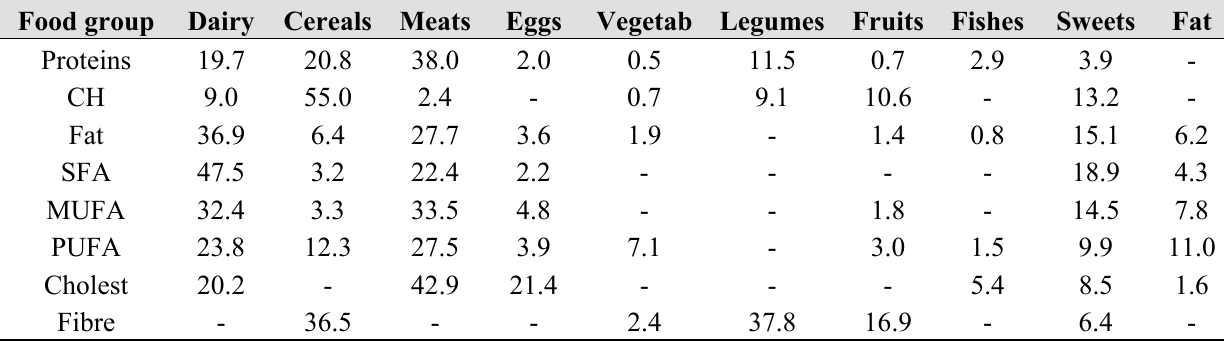
Table 4. Percentage contribution (%) of the different food groups to daily macronutrients intake. Food group Dairy Fruits